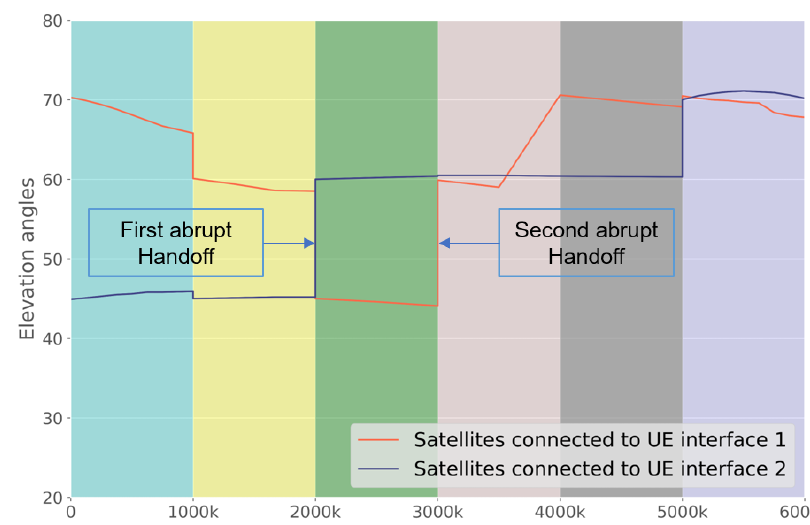
Figure 3. Elevation angles of the pair of satellites connected to the UE in different contexts.